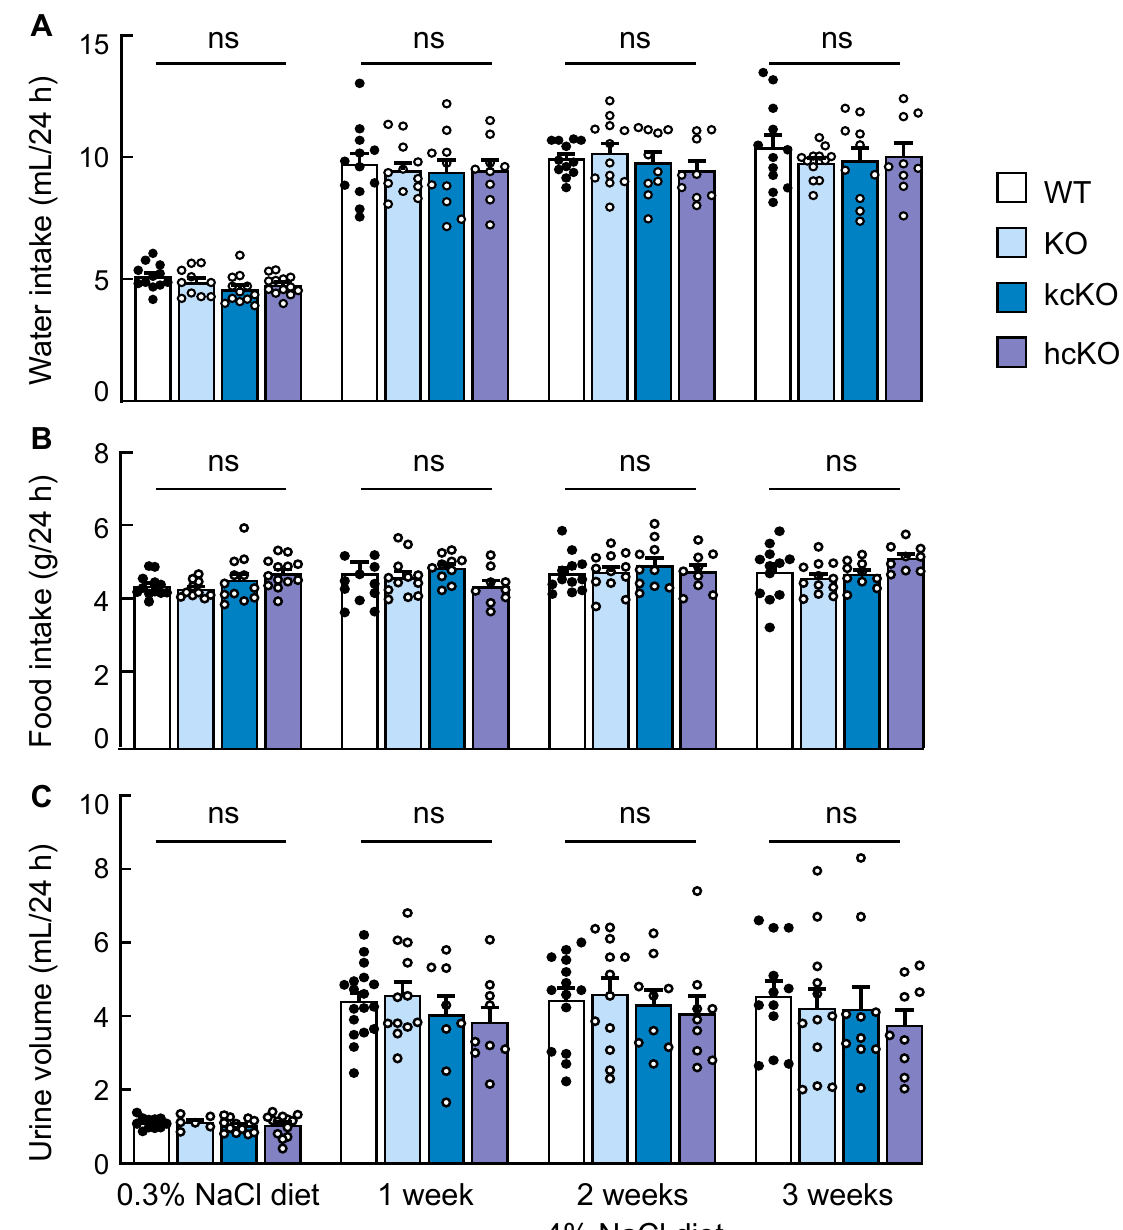
Figure 6. Water and food intakes and urine volume in corin KO, kcKO, and hcKO mice. ( A – C ) Water ( A ) and food ( B ) intakes and urine volume ( C ) were measured in male WT (black dots), corin KO, kcKO, and hcKO (white dots) mice on 0.3% and 4% NaCl diets for one to three weeks. n = 8–18 per group. Data shown are mean ± SEM. p -values were analyzed by one-way ANOVA ( A ) or Kruskal– Wallis test ( B , C ). ns, not significant.